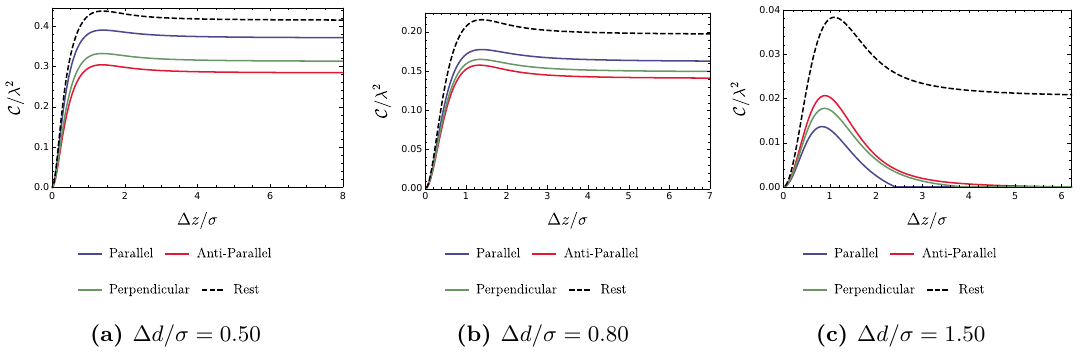
Figure 9. The concurrence is plotted as a function of ∆ z/σ for various separation ∆ d/σ = { 0 . 50 , 0 . 80 , 1 . 50 } . Here, we have set Ω σ = 0 . 10 and aσ = 0 . 50 . In the limit of ∆ z → 0 , the concurrence C ( ρ AB ) approaches zero regardless of the value of the separation ∆ d